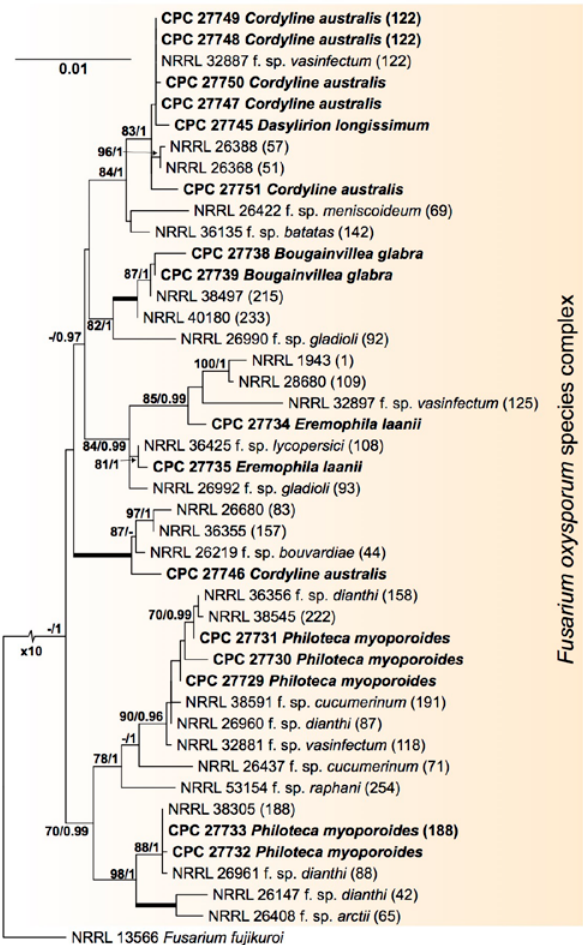
Figure 3. Maximum-likelihood (ML) phylogram of the Fusarium oxysporum species complex obtained from combined EF-1α and IGS sequences of isolates obtained in this study and representatives of the most closely related haplotypes. Branch lengths are propor- tional to distance. Numbers on the nodes are ML bootstrap values greater than 55%; and Bayesian posterior probability values greater than 0.95. Full supported branches and isolates obtained from orna- mentals plants are indicated in bold. Numbers between parentheses indicate the corresponding